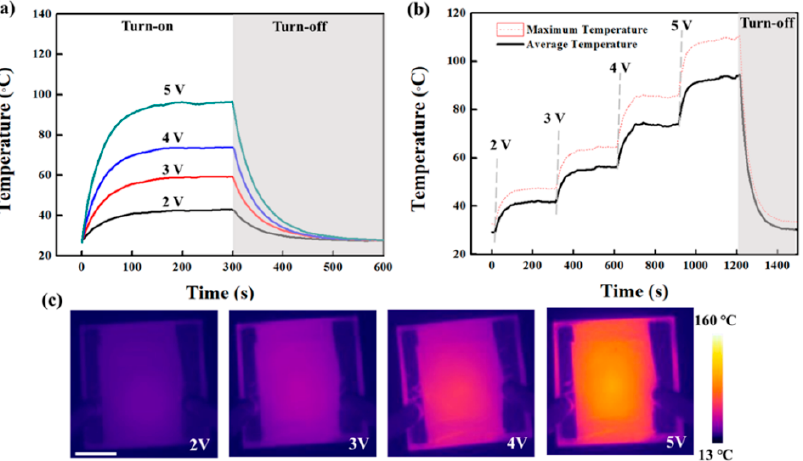
Figure 5. ( a ) Time-dependent temperature of thick Ag NWs network-based film heaters (20 × 20 mm 2 ) under operation at different voltages. ( b ) Temperature evolution of thick Ag NWs network-based film heaters at stepwise voltage rise from 2 to 5V. ( c ) Temperature profiled of 20 × 20 mm 2 electrodes, measured using an IR camera. (scale bar = 6.5 mm).